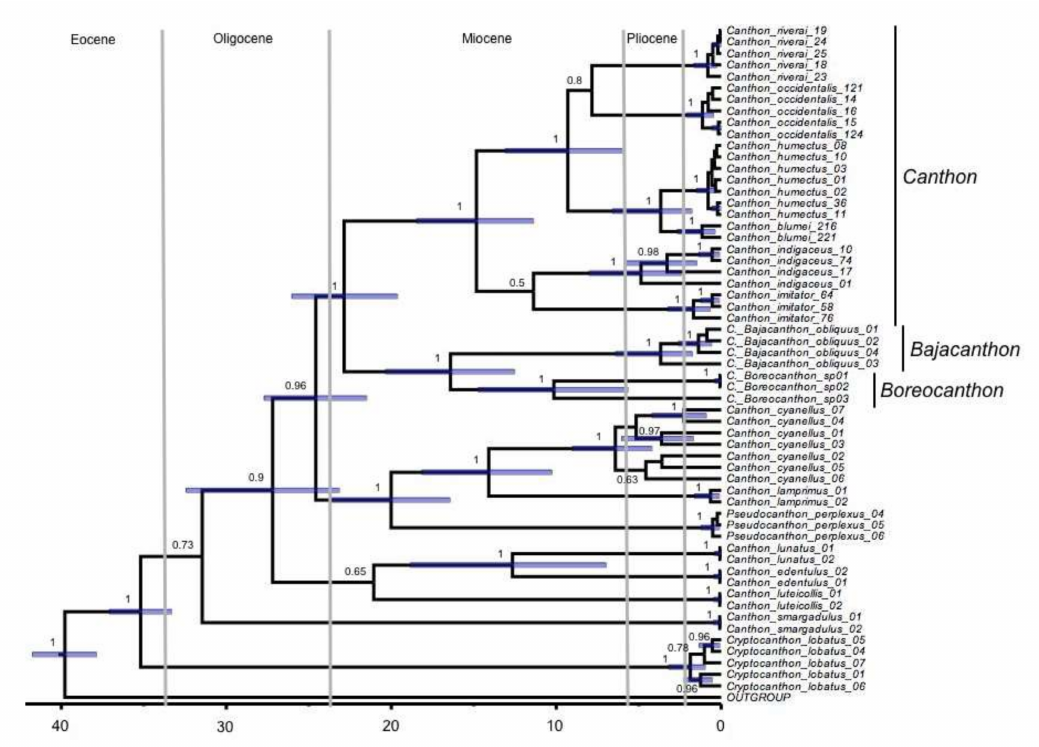
Figure 4. Chronogram for the phylogenetic history of Canthon ( Bajacanthon ) obliquus and closely related taxa. Numbers at nodes indicate Bayesian posterior probability values. Node bars indicate the 95% Highest Posterior Density for splitting age in nodes with a Bayesian posterior probability higher than 0.9. The temporal reconstruction supports Kohlmann and Halffter’s conclusion that the origin of Bajacanthon took place during the Miocene (16.5 Mya) [5]. This subgenus is more closely related to the subgenus Boreocanthon than to other Canthon species from North or South